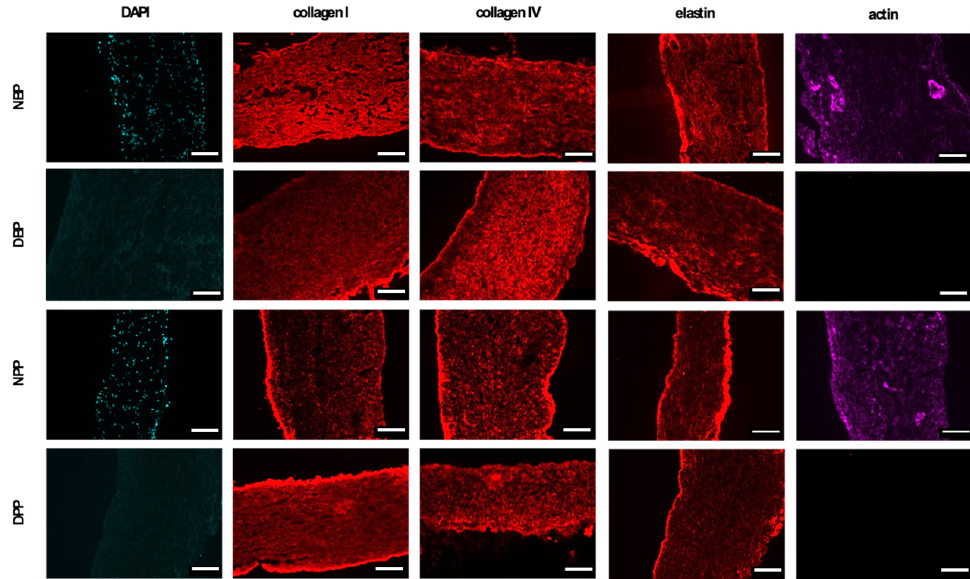
Figure 3. Immunofluorescence staining: rows indicate the investigated tissue and columns corre- spond to each specific staining (scale bar = 100